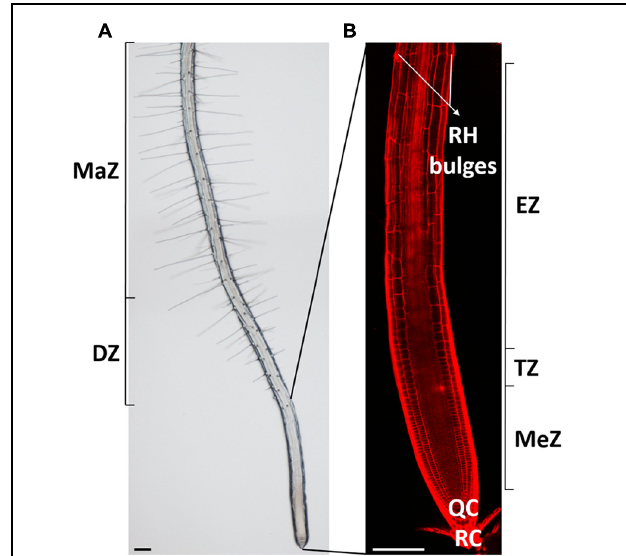
FIGURE 1 | Overview of the Arabidopsis thaliana root and its developmental zones. (A) Bright-field and (B) confocal picture of a 7-day-old Arabidopsis thaliana root with its distinct developmental zones. RH, root hair; MaZ, maturation zone; DZ, differentiation zone; MeZ, meristematic zone; TZ, transition zone; EZ, elongation zone; QC, quiescent center, and RC, root cap. Scale bar = 100 μ